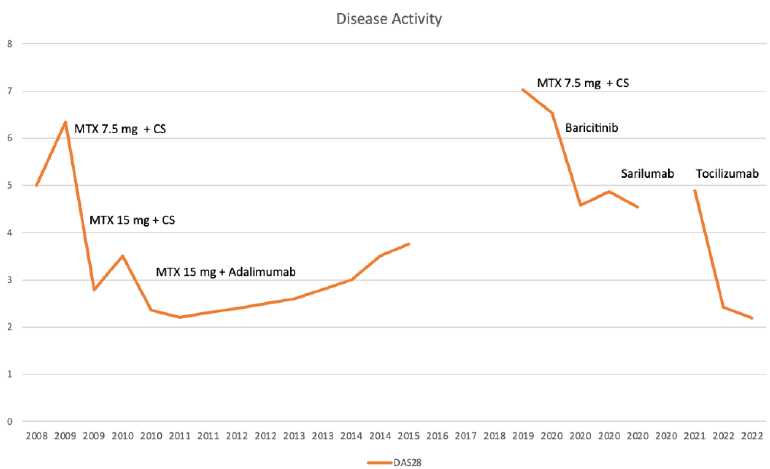
Figure 6. Modified Disease Activity Score (DAS28) during follow-up. Therapy and disease activity evaluation had to be interrupted between 2015 and 2019, as the patient moved to another country. NSAIDs = non-steroidal anti-inflammatory drug; CS = corticosteroids; MTX =